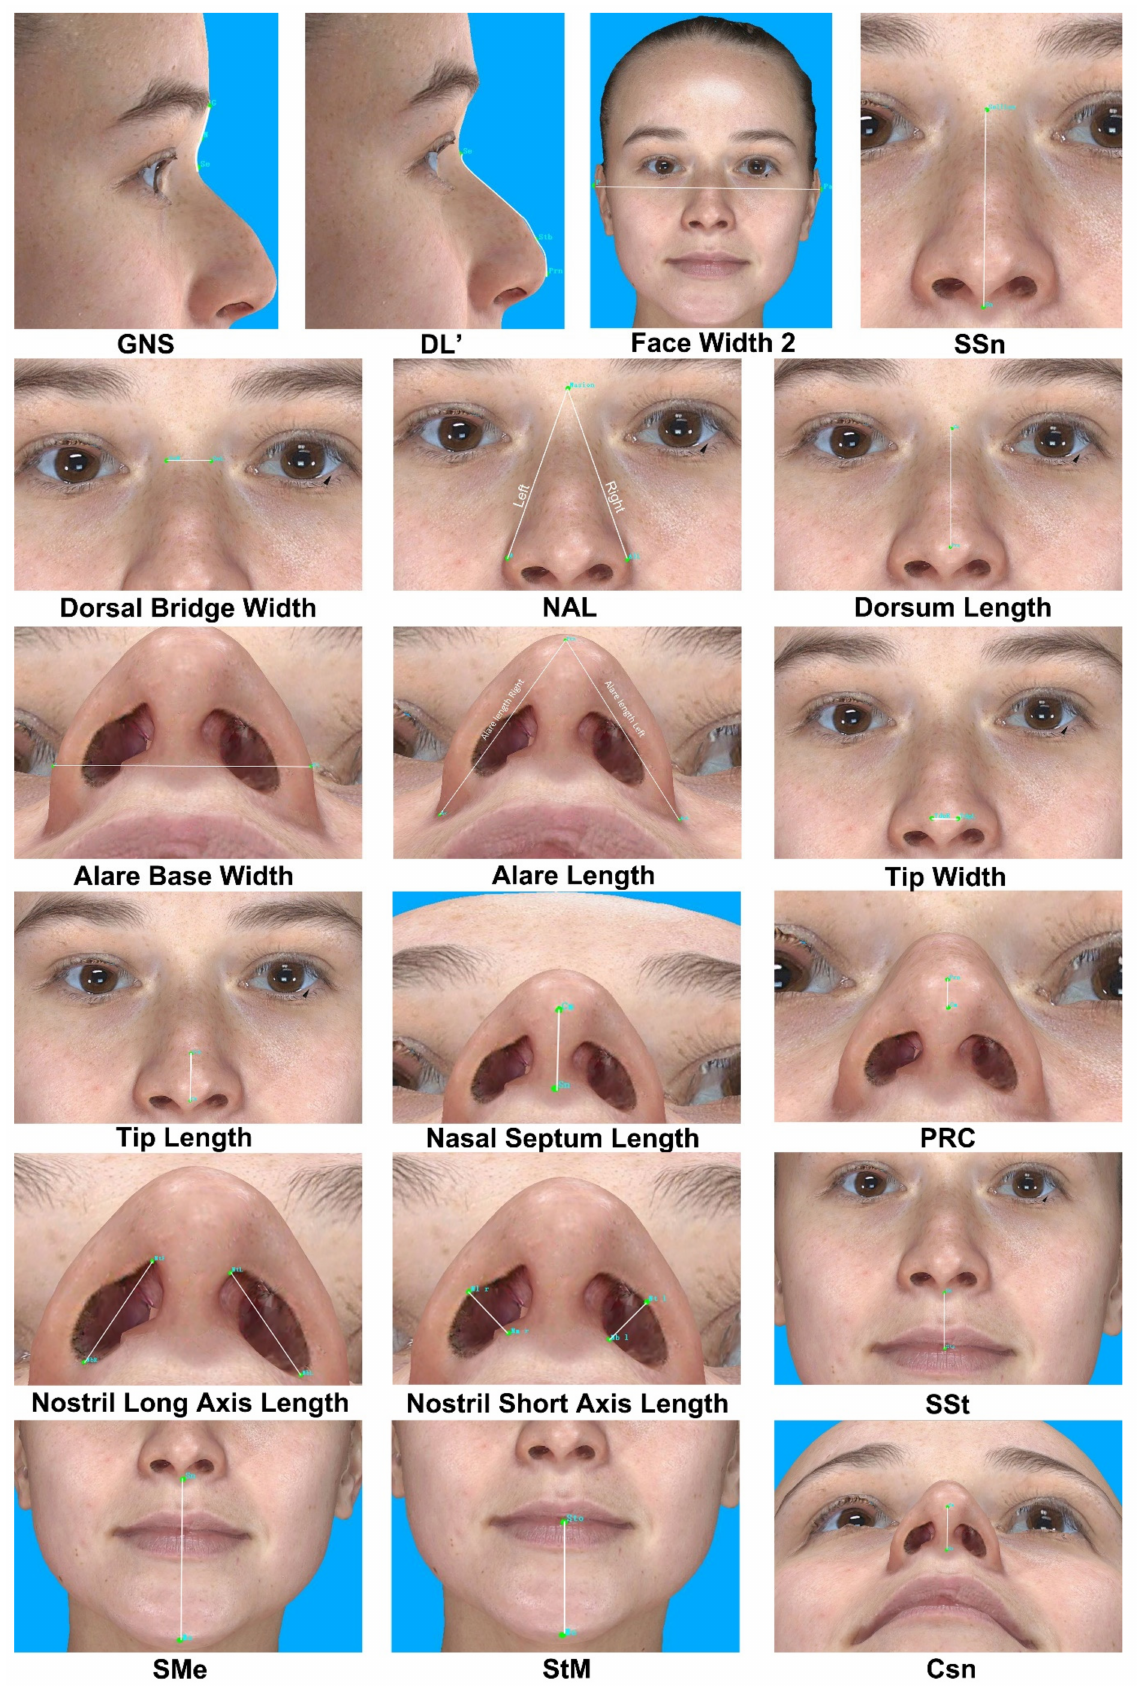
Figure 3. The linear measurements of novel